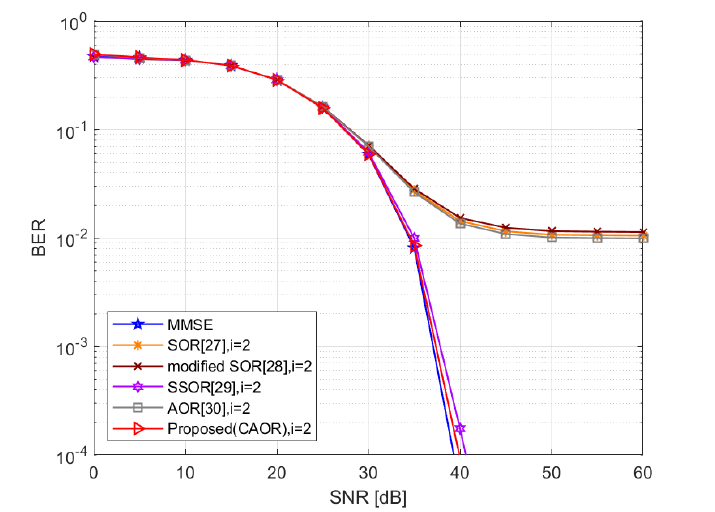
Figure 5. BER performance comparison for different detection schemes, N R × N T = 128 × 16.